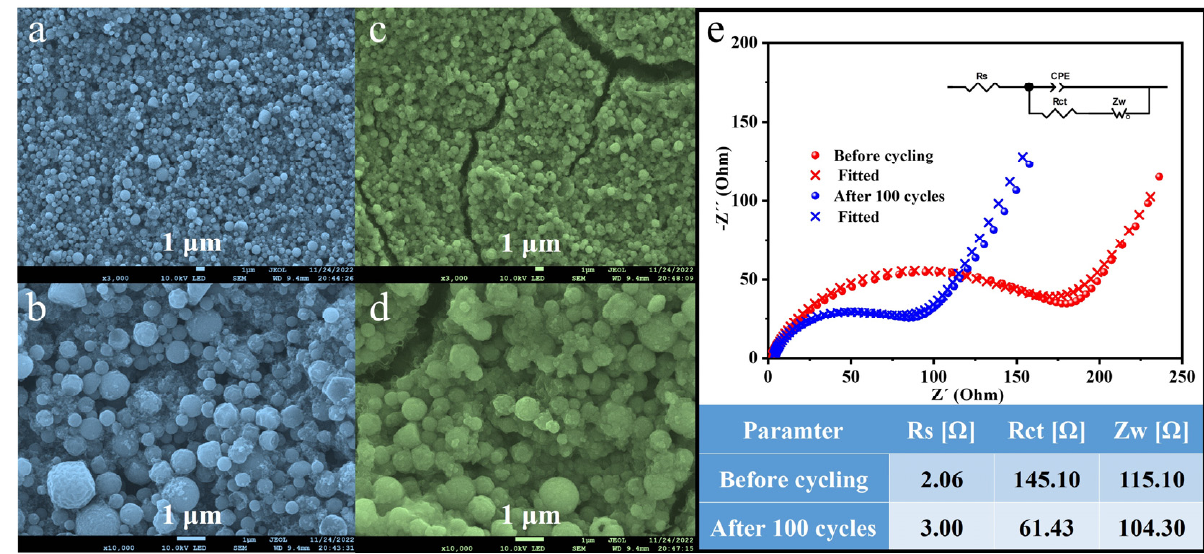
Figure 7. FESEM images of the Fe 3 O 4 @C electrode before cycling ( a , b ) and after 100 cycles ( c , d ) under the corresponding magnifications; Nyquist plots of the Fe 3 O 4 @C electrode before cycling and after 100 cycles with the equivalent circuit and parameters obtained by fitting the EIS data ( e ). The Nyquist plots of the Fe 3 O 4 @C electrode before cycling and after 100 cycles are shown in Figure 7e. The high frequency region usually contains one or two semicircles corresponding to the formation of SEI (Rf) and charge transfer resistance (Rct), respectively, while the low frequency region contains only an inclined straight line representing the Warburg impedance (Zw) of lithium-ion diffusion [35]. By using ZView software, the fitted parameters of the two curves are calculated based on the inset equivalent